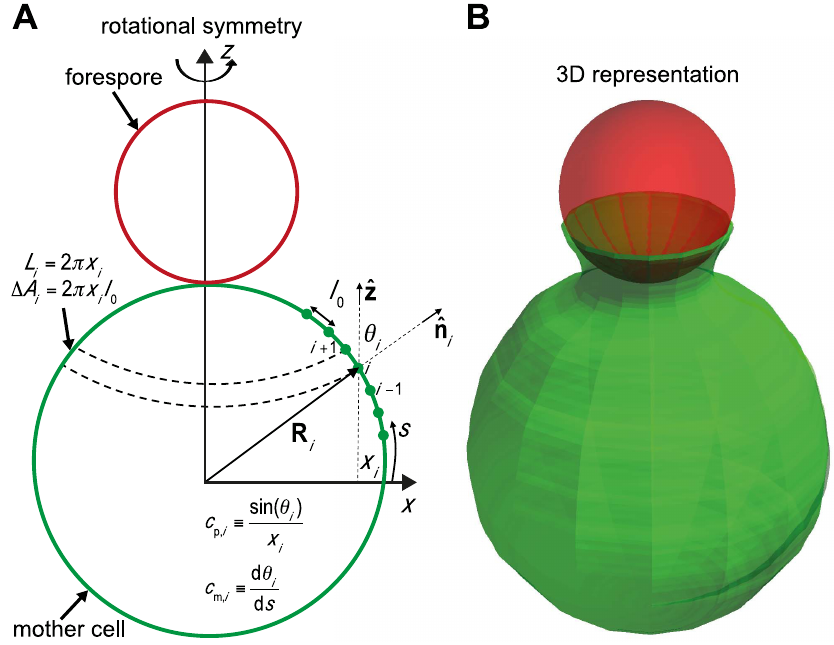
Figure 4. Engulfment model and Langevin simulations. (A) 3D mother-cell membrane is represented by a string of beads assuming rotational symmetry around z -axis. Each bead at position ( x i , z i ) represents a ribbon of width l 0 and length L i . Forespore is modeled as a solid sphere. See Materials and Methods, and Text S1 for further model explanations. (B) Snapshot of 3D simulation showing example of early-stage engulfment.